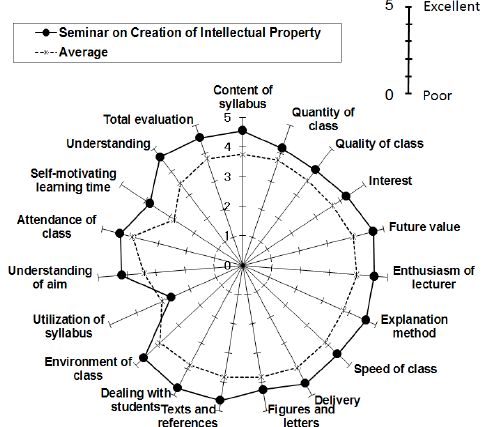
Figure 4. Student evaluation of Seminar on Creation of Intellectual Property